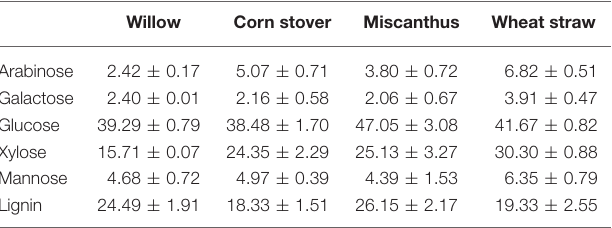
TABLE 3 | Main effects of factors on total xylose release from feedstock via SE-PT n =